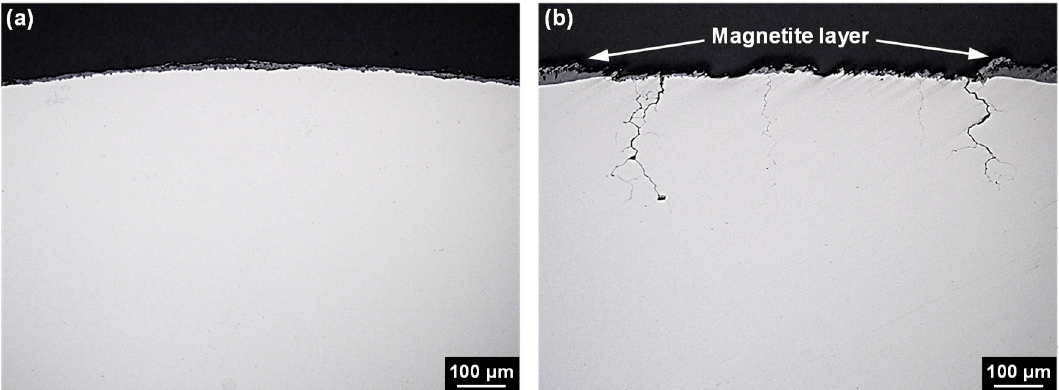
Figure 4. Cross-sectional optical microscope (OM) images of the Alloy 600 SCC specimens after the SCC tests: ( a ) magnetite-free SCC specimen and ( b ) magnetite-deposited SCC specimen.